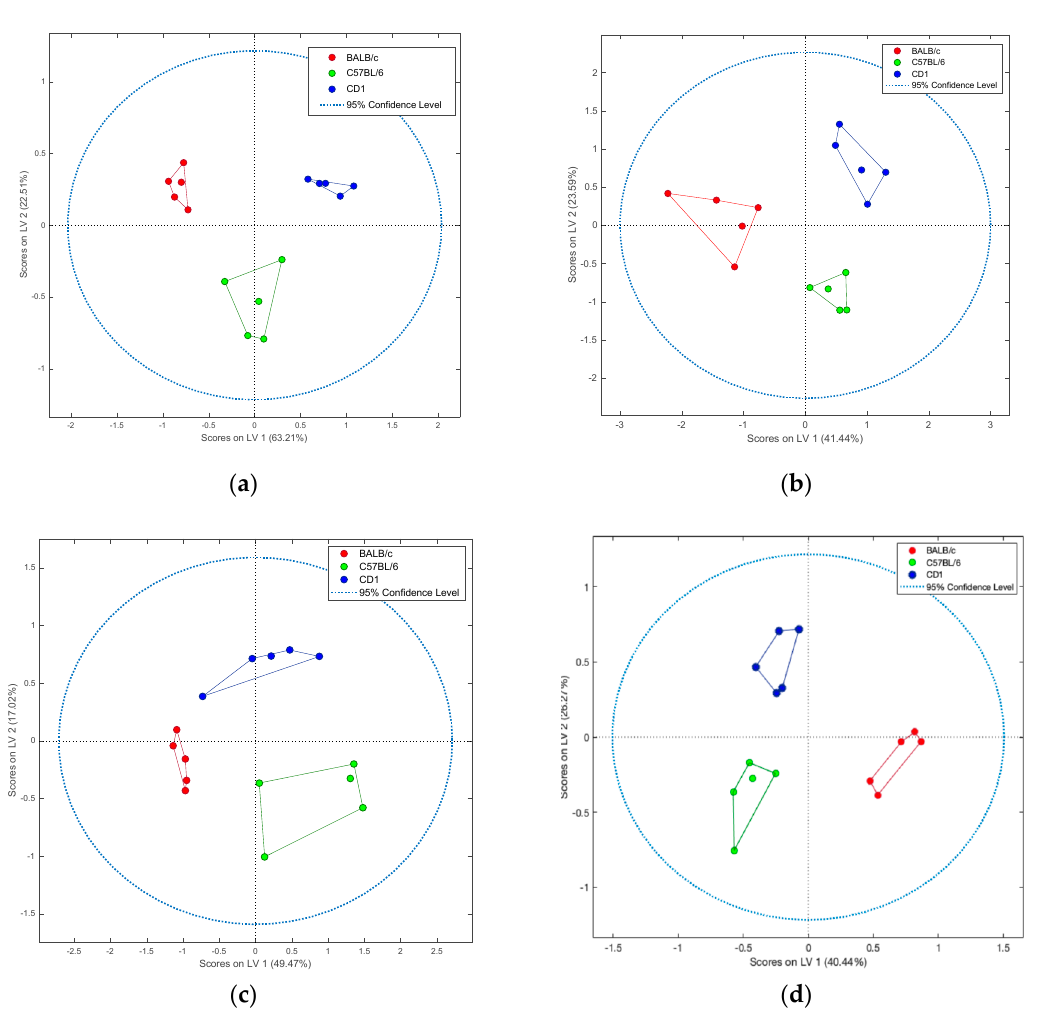
Figure 4. Score plots (PLS-DA) of selected metabolites in tissues collected from three different mouse strains. Examined strains included: BALB/c (red), C57BL/6 (green), and CD1 (blue). Tissues analyzed included: brain ( a ), liver ( b ), kidney ( c ), and muscle ( d ).